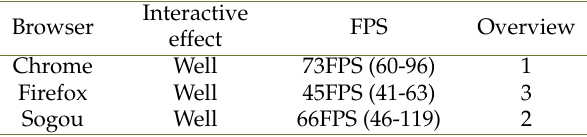
Table 8. Results of browser compatibility test